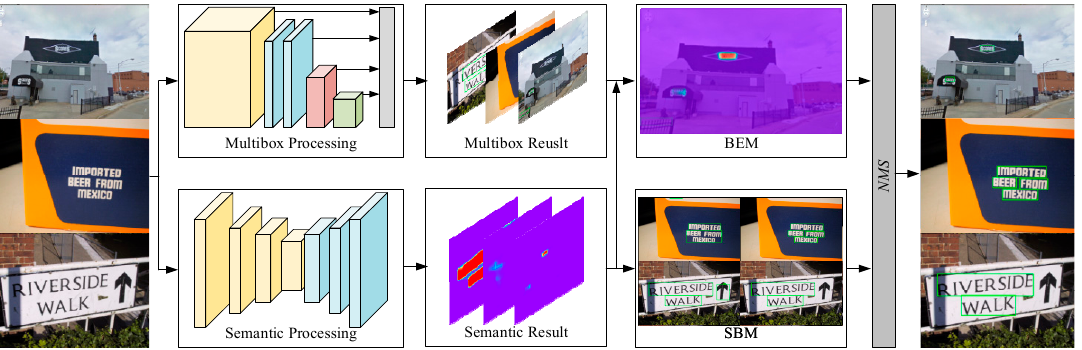
Figure 4. Framework of scene text detection algorithm using multibox and semantic segmentation.